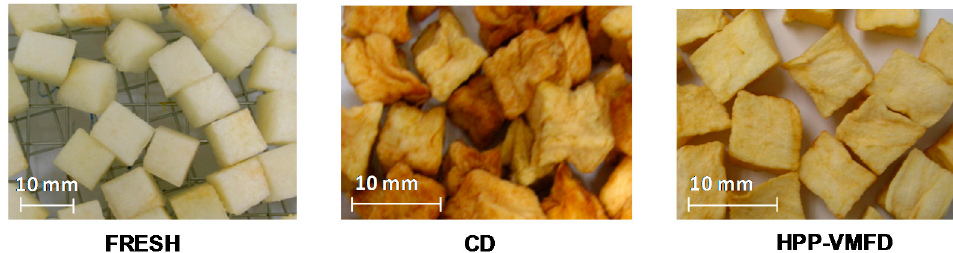
Figure 6. Appearance of apple cubes dehydrated by convective drying (CD) and vacuum microwave finish drying (HPPD-VMFD).